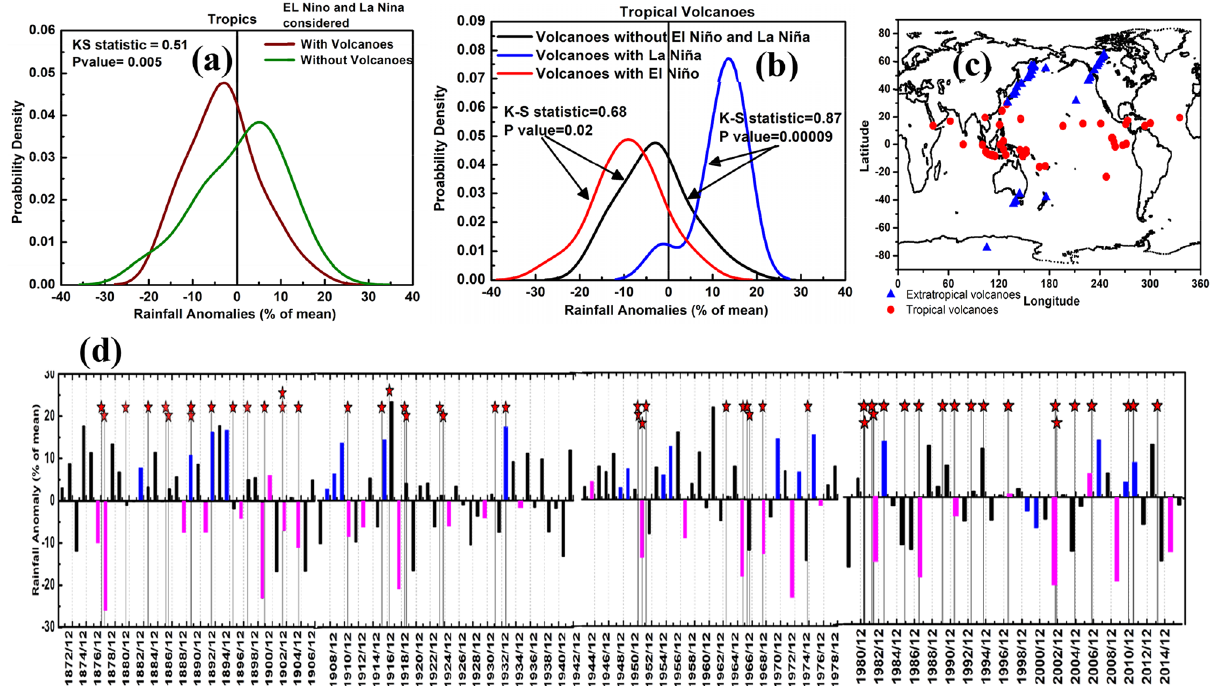
Figure 1. Volcanic eruptions and Indian summer monsoon rainfall: ( a ) probability distribution of rainfall anomalies within two years of eruption, when stratified with and without tropical volcanic eruptions; ( b ) probability distribution of rainfall anomalies within two years of a tropical volcanic eruption during El Niño, La Niña, and normal years; the statistical measures of K-S test shown in ( a , b ) indicates that distributions are distinct; ( c ) spatial distribution of moderate-to-large (VEI > 3) volcanic eruptions; ( d ) time series of June– September mean precipitation anomaly (%) during 1871 –2016 along with tropical (30° S–30° N) volcanic eruptions indicated with stars. Bars in magenta and blue in panel ( d ) indicate El Niño and La Niña years, respectively. Details of the volcanic eruption are listed in Table S1. Anomalies are obtained as difference in rainfall amount of the respective year and climatology of 1871–2016 (figure created using the COLA/GrADS software).